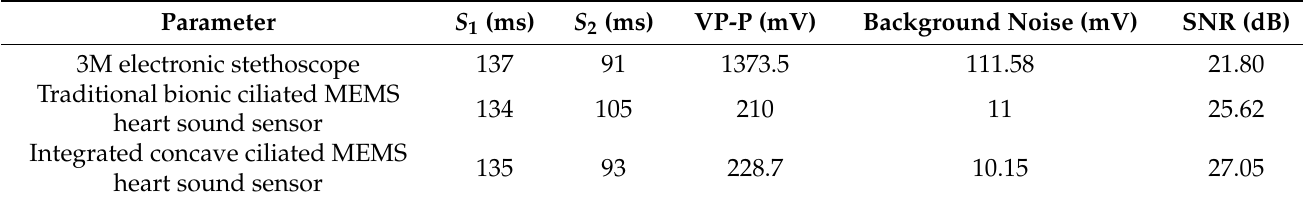
Figure 16. ( a ) The heart sound test results of bionic MEMS heart sound sensor; ( b ) the static noise of bionic MEMS heart sound sensor. ( c ) Frequency spectrum of heart sound signal. Table 4. Heart sound signal test data.